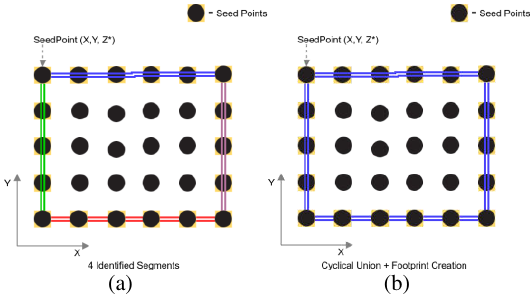
Figure 8. (a) Identification of wall segments in a given scene (b) Cyclical Merging of segments to form potential building